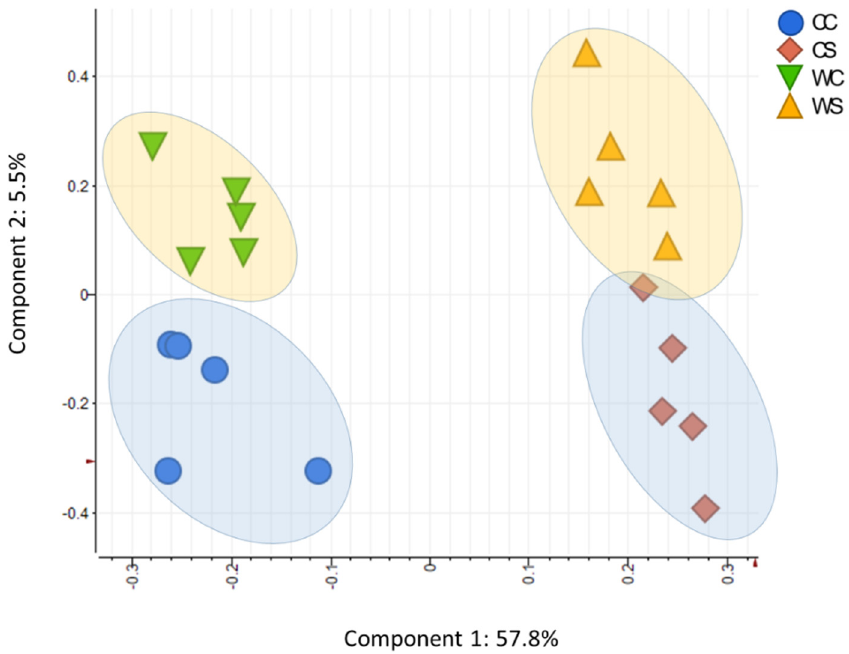
Figure 5. Partial least squares discriminant analysis (PLS-DA) based on both primary metabolites and lipids. CC, Condor Control; CS, Condor Stress; WC, Wadielniel Control; WS, Wadielniel Stress. Data from five independent biological replicates were used to perform the PLS-DA.